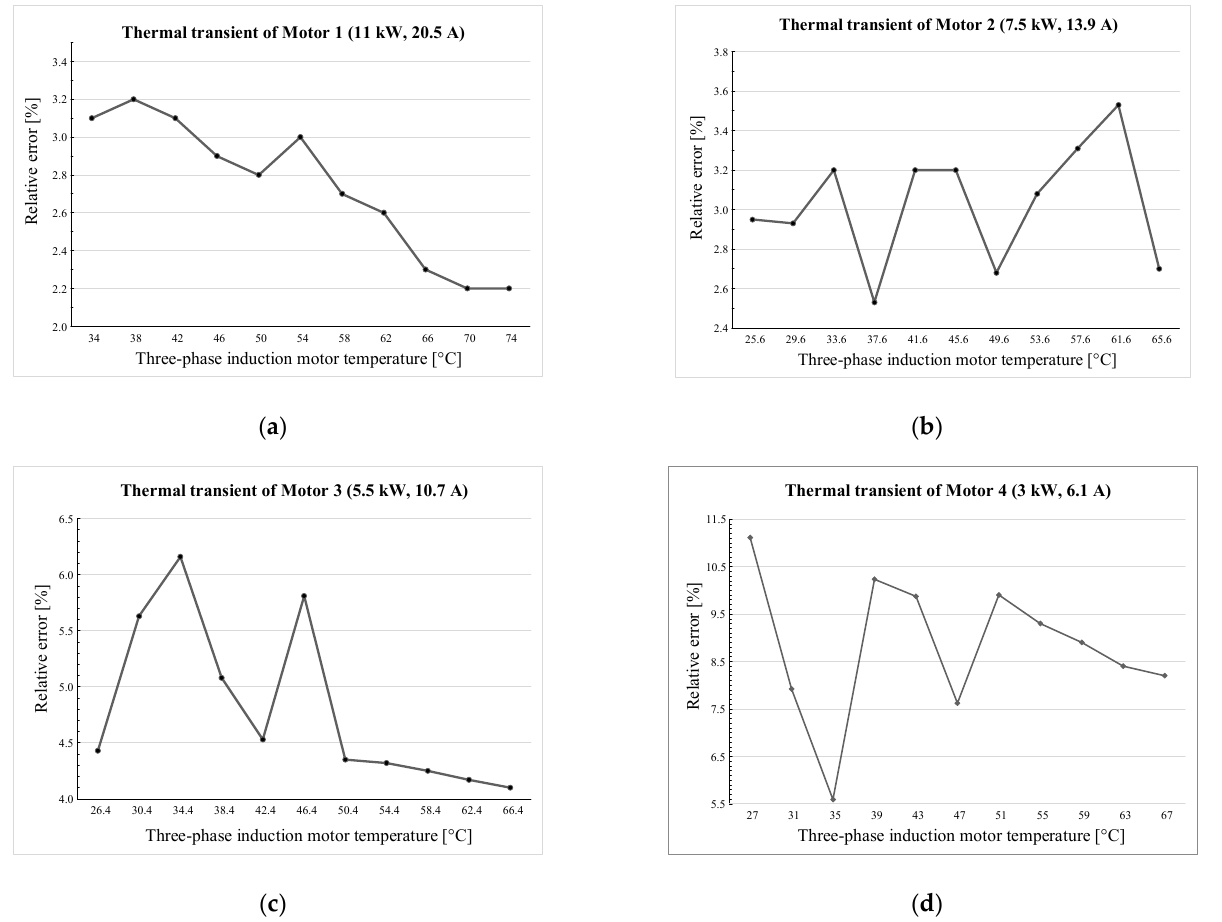
Figure 13. The relative error for thermal transient evaluated for the four considered three-phase induction motors. ( a ) Motor 1: 11.5 kW, 20.5 A; ( b ) Motor 2: 7.5 kW, 13.9 A; ( c ) Motor 3: 5.5 kW, 10.7 A; ( d ) Motor 4: 3 kW, 6.1 A.